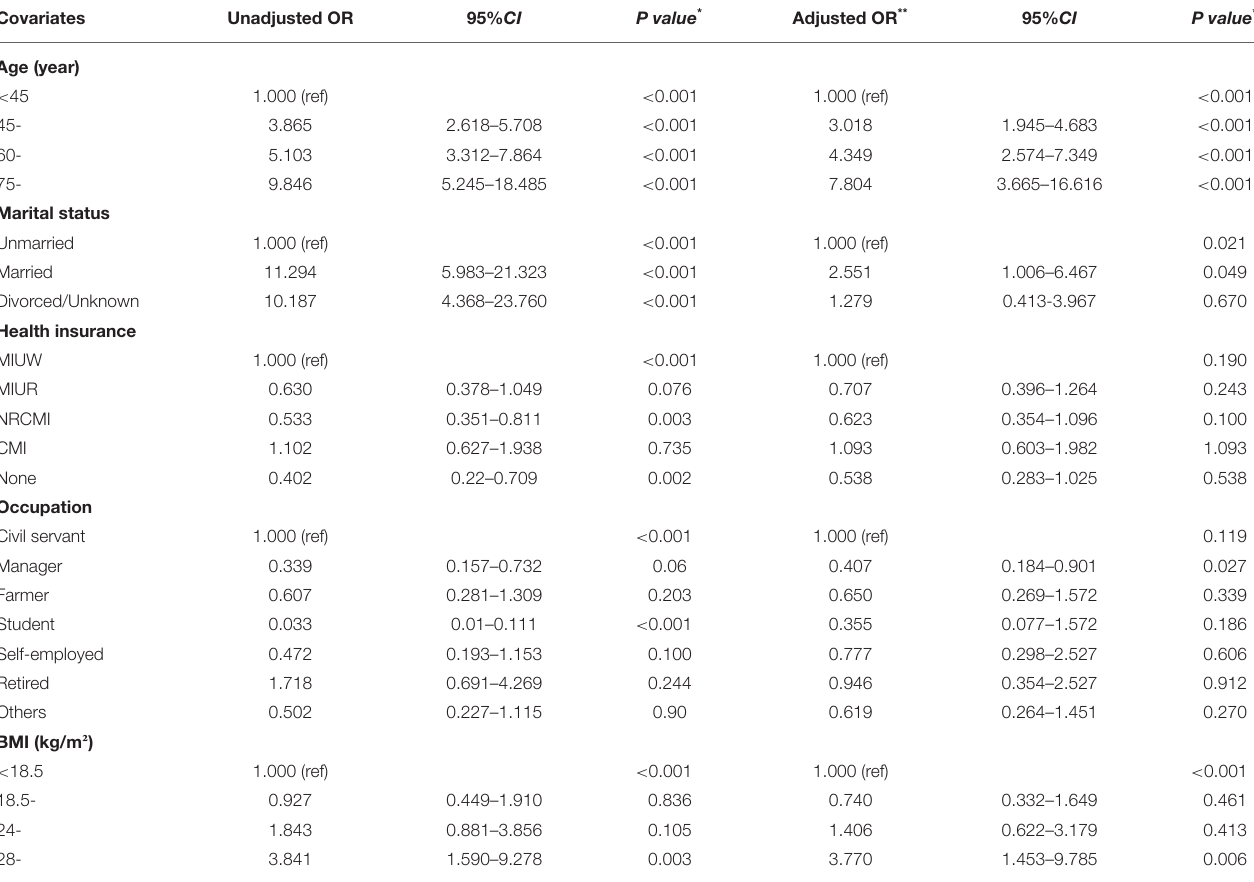
TABLE 2 | Associations between multimorbidity and socio-demographic and BMI. Covariates Unadjusted OR